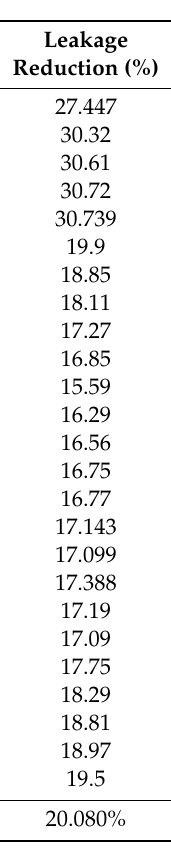
Table 3. The optimal pressure value of the pressure-reducing valve (PRV) ( P set ) in meters, obtained after applying the proposed algorithm considering di ff erent load